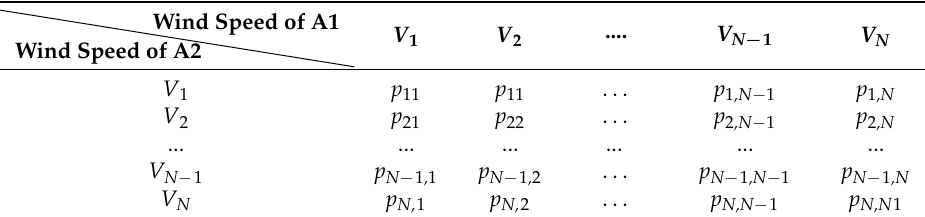
Table 1. Joint probability of sectionalized wind speed of two wind